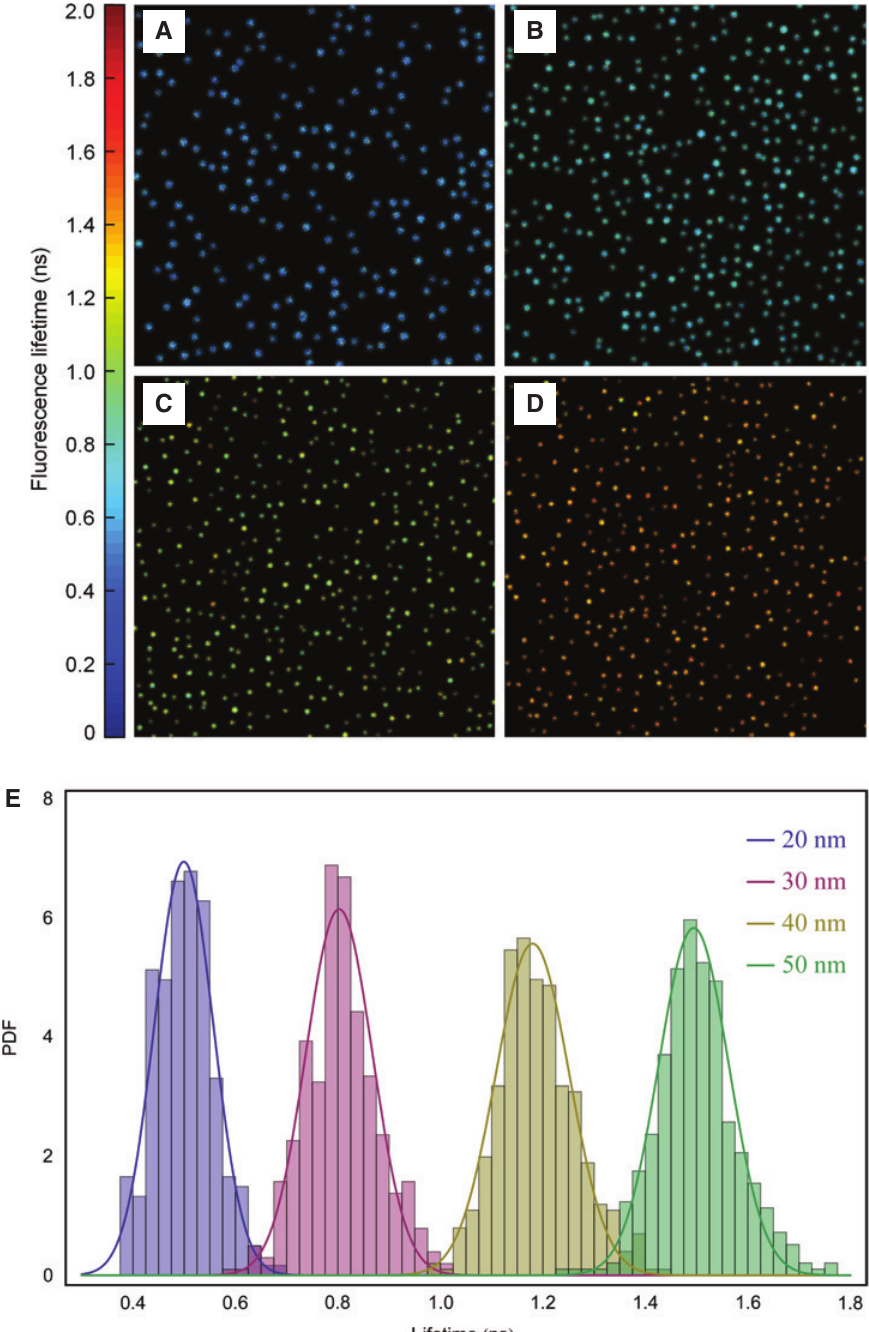
Figure 4: Single-molecule MIET of surface adsorbed fluorescent molecules. Lifetime images of single Atto 655 molecules (Atto-Tec) spin-coated on MIET substrates with (A) 20 nm, (B) 30 nm, (C) 40 nm, and (D) 50 nm SiO spacer thicknesses. Each image shows a sample area of 30 m × 30 m. The color bar shows the color index for lifetime values in 2 nanoseconds. (E) Lifetime distributions for the four samples. Data taken from